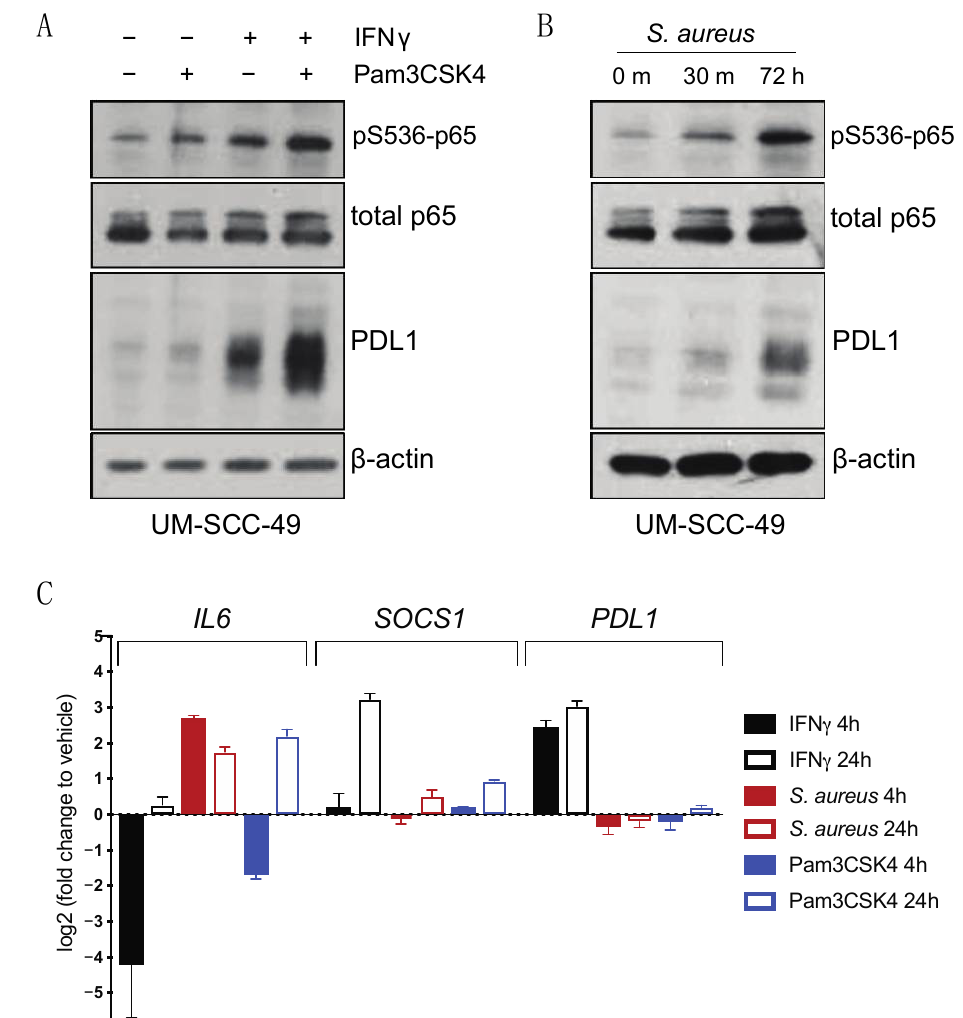
Figure 4. TLR2 agonists drive PDL1 protein accumulation in UM-SCC-49 cells. ( A ) UMSCC49 cells were treated with or without 300 ng/mL Pam3CSK4 (Invivogen) with or without 10 ng/mL IFNγ for 72 h. ( B ) UM-SCC-49 cells were treated for indicated duration with 0.075% S. aureus (Millipore) and lysates were analyzed by immunoblot. ( C ) qPCR analysis of IFNγ and TLR effectors and PDL1 expression in UM-SCC-49 treated with S. aureus or Pam3CSK4 for either 4 h or 24 h as indicated.